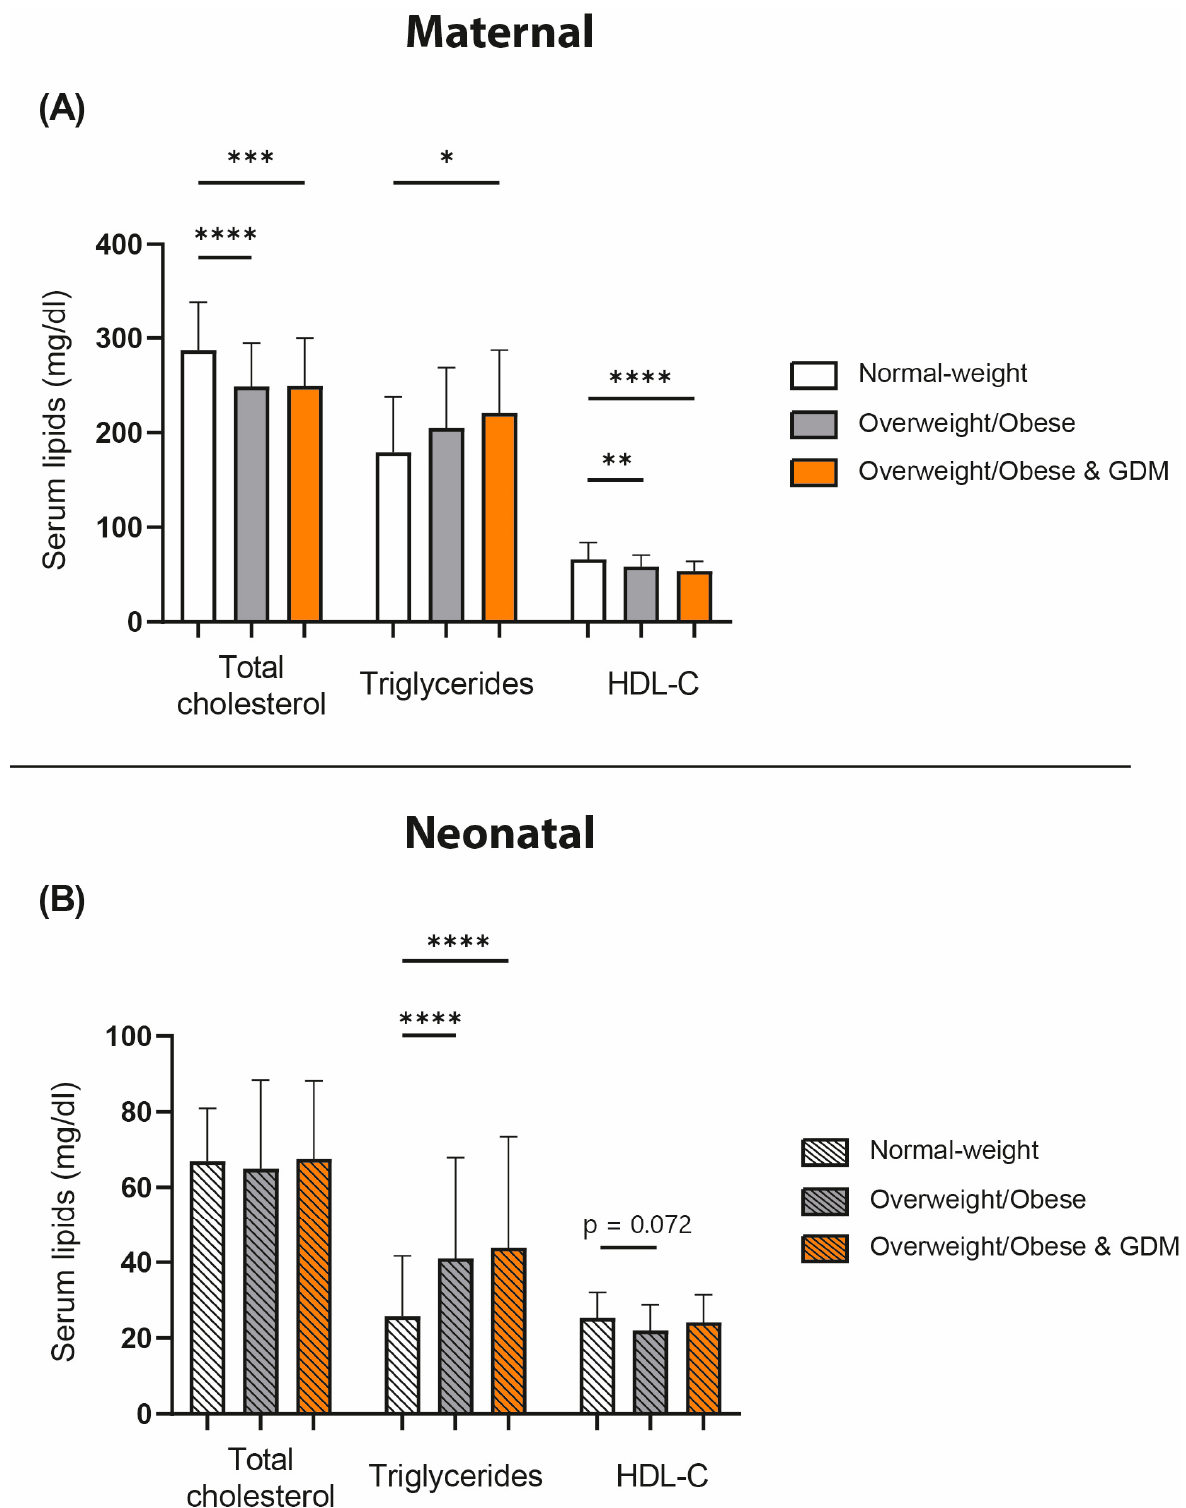
Figure 1. Differences between serum lipid levels in normal-weight and overweight/obese pregnant women and in women diagnosed with GDM and its impact on their offspring: ( A ) shows serum total cholesterol levels, triglycerides, and HDL-C of mothers and ( B ) of neonates. Data are presented as mean and standard deviation. * p < 0.05, ** p < 0.01, *** p < 0.001, **** p < 0.0001.